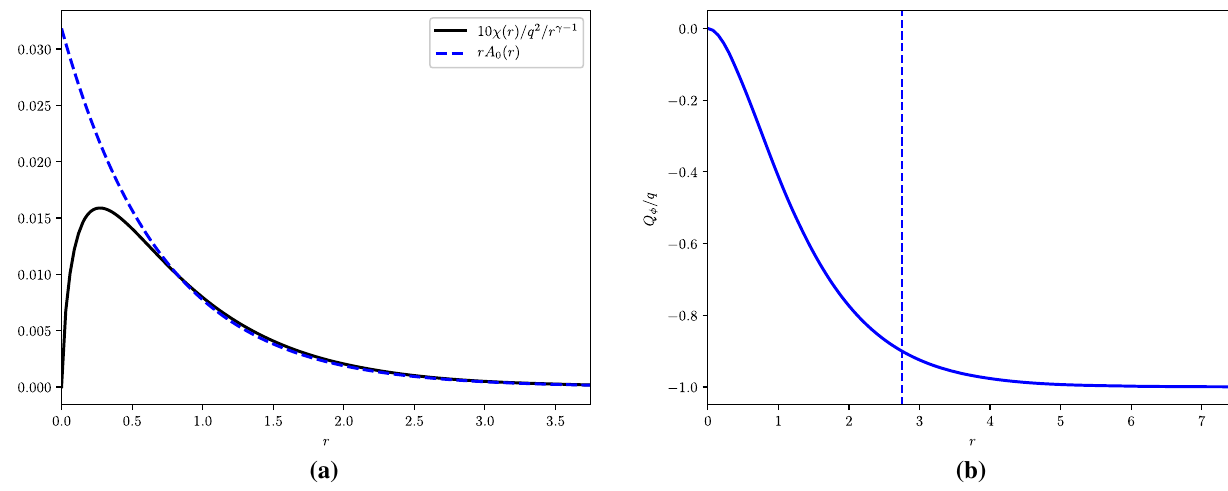
Fig. 1 a The profile functions A 0 and χ of a solution for point charge; β = 2 . 0, q = 0 . 4. b The charge distributions of the same solution. The dashed vertical line shows r = R c